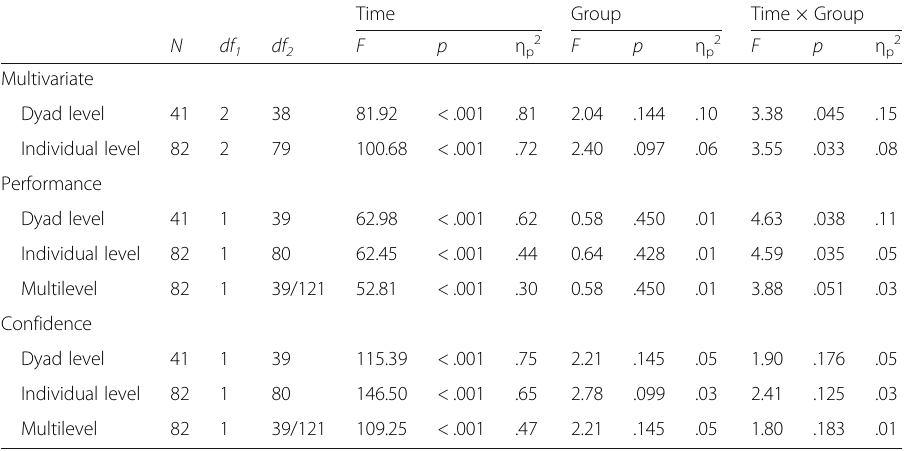
Table 1 Inferential statistics of the MANOVA for dyads and individuals and multilevel